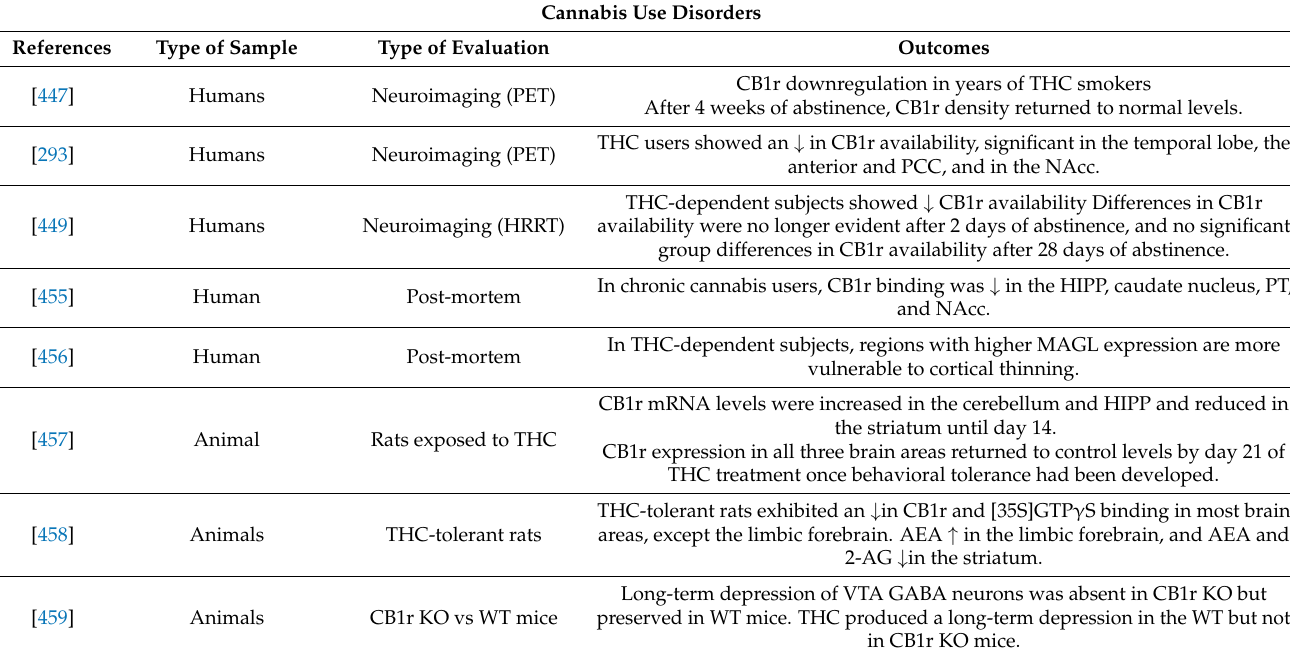
Table 3. Summary of main findings regarding the alterations of the ECS components in animals and human studies in Cannabis Use